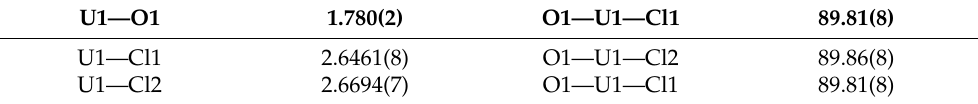
Table 3. Selected geometric parameters (Å, ◦ ) for II .